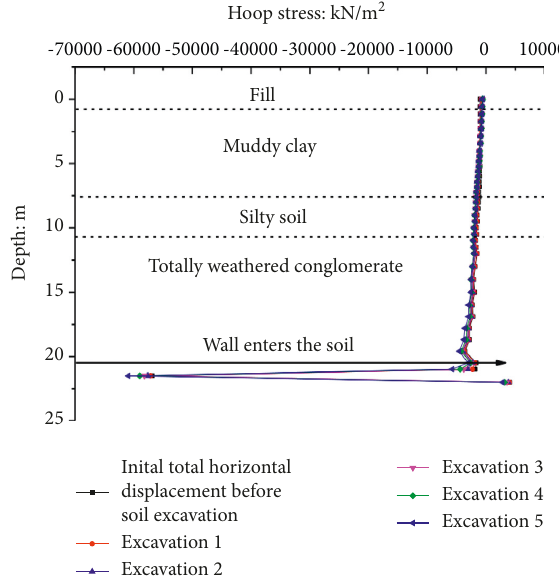
Figure 21: Circumferential stress distribution of H-bar between Gutter 7 and Gutter 8 with depth after soil